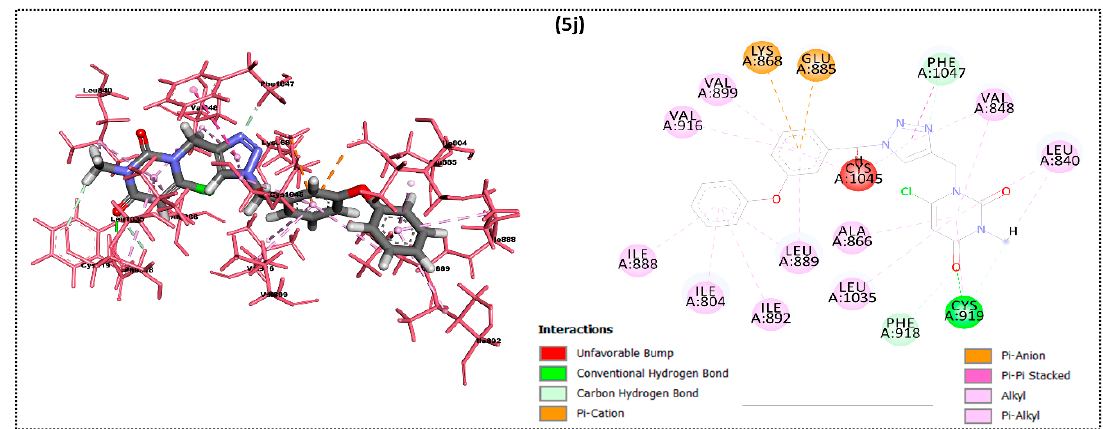
Figure 8. Docking interactions (3D & 2D) of 5j with the receptor protein, VEGFR-2 transferase. Critical amino acid residues are shown in the stick model and pink colour.